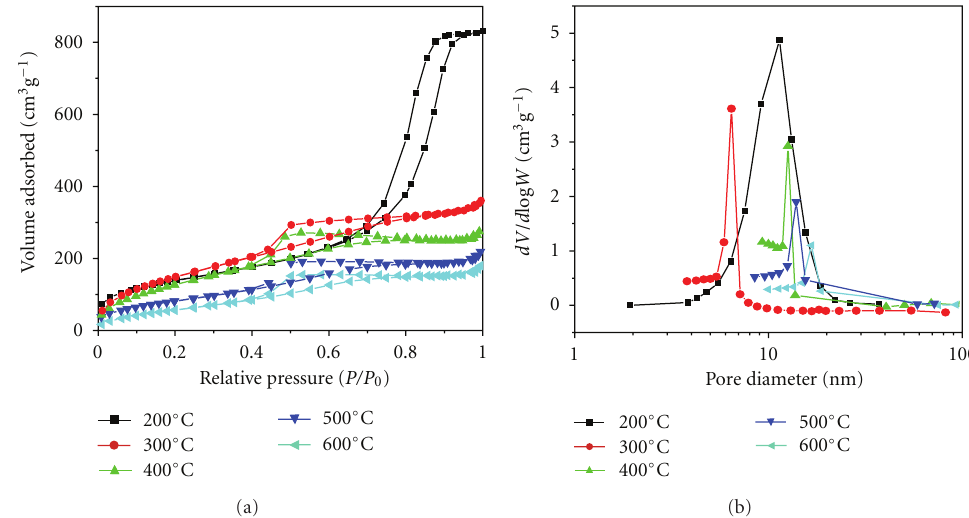
Figure 3: N 2 adsorption/desorption isotherms (a) and the corresponding BJH pore size distributions (b) of the as-prepared IT-T samples.